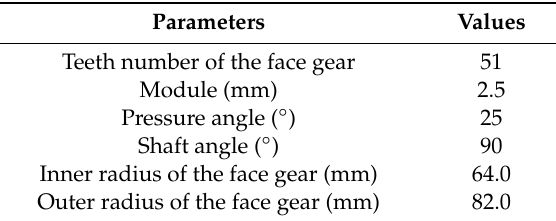
Table 1. Main parameters of the face gear.